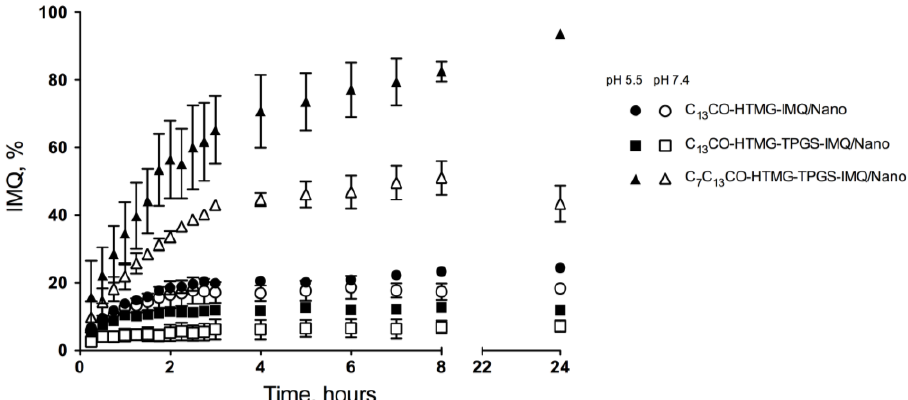
Figure 5. In vitro pH-dependent release profiles of IMQ from the selected micelles at pH 5.5 and pH 7.4 (mean ± standard deviation (SD), n = 3).